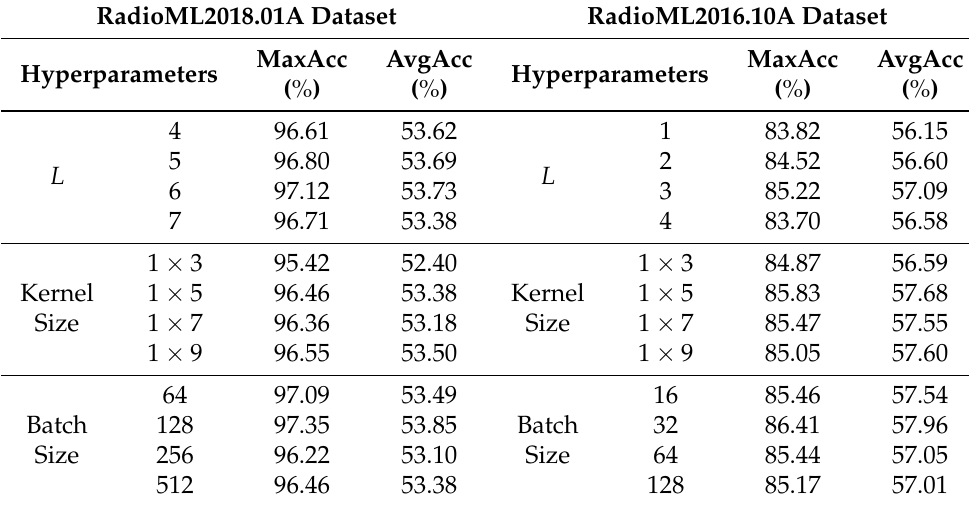
Table 4. Comparison of different network